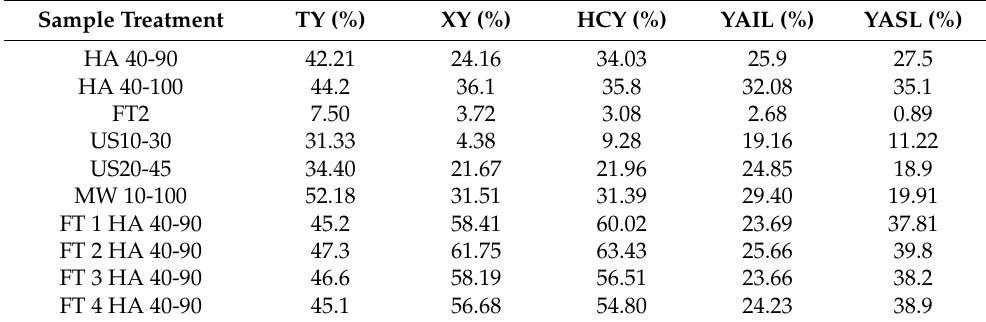
Table 3. The effect of freeze–thawing cycles on the subsequent yields obtained in alkaline extraction. Sample